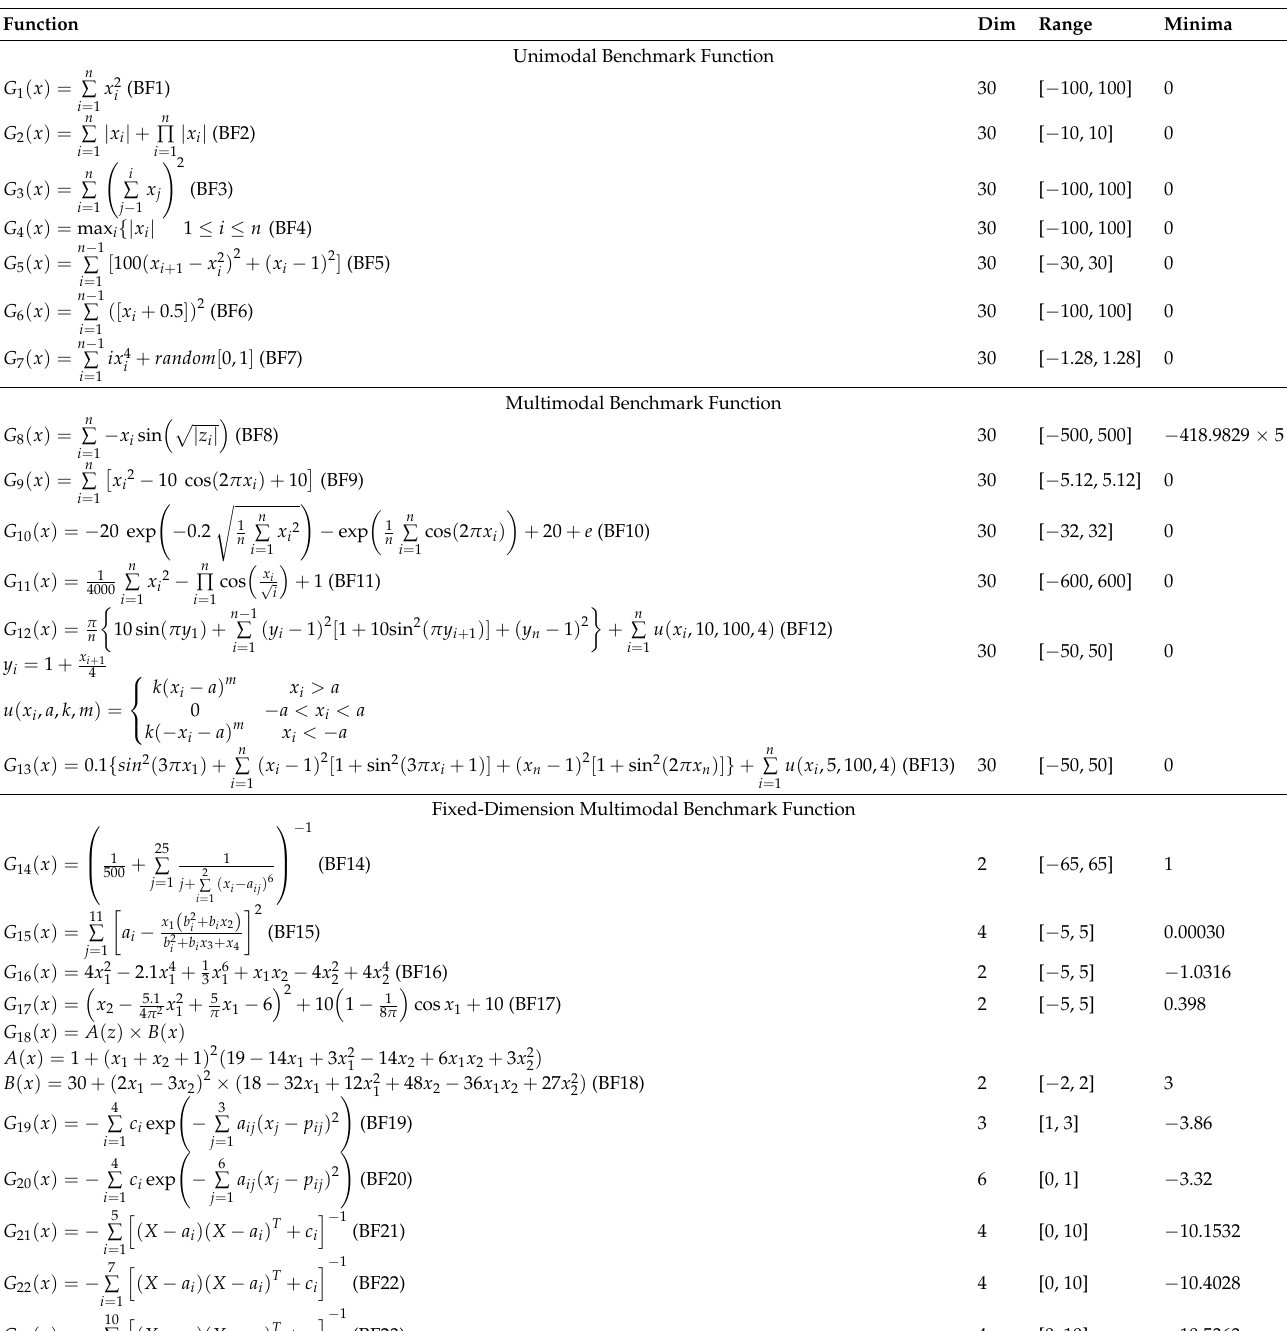
Table 1. Details of Benchmark Functions Suite